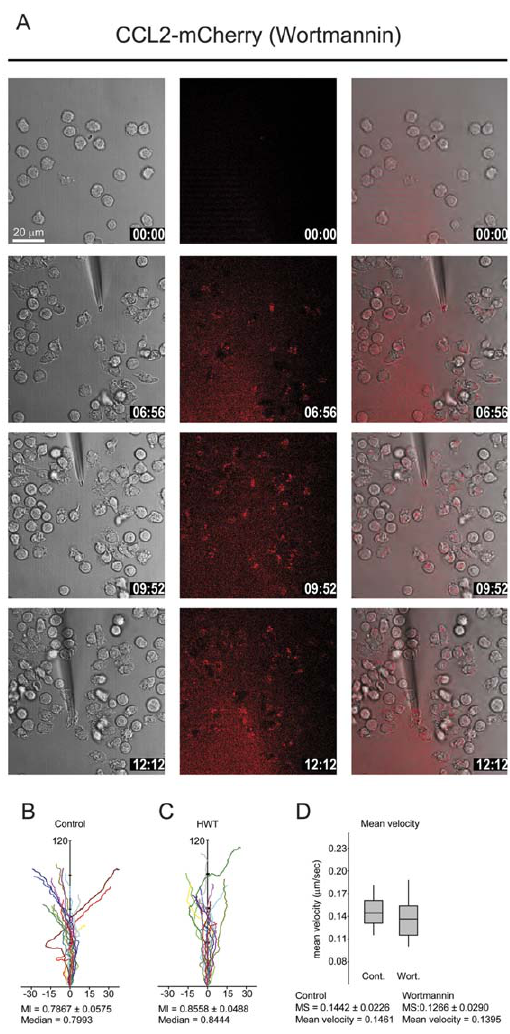
Figure 8. Inhibition of PI 3-kinase does not affect CCL2 uptake and monocyte migration. (A) Selected frames from time-lapse video microscopy (Movie S9) of migrating human monocytes recorded at 37 u C. Monocytes were pretreated with 100 nM wortmannin for 30 min. The micropipette was dispending 100 nM CCL2-mCherry with constant backpressure. Gray (left column) corresponding phase image. Left panels phase images, middle panels CCL2-mCherry (ex 594 nm/em 620–680 nm), and right overlay. Time stamps are indicated in mm:ss. (B and C) Analysis of directionality and velocity of monocytes: effect of PI 3-kinase inhibition. Tracks of monocytes (recorded as in Fig. 1 or Fig. 8A) either untreated (B) or pretreated with 100 nM wortmannin (C) were analyzed and plotted aligning their average directional vector with the y-axis (distance in m m). (D) Mean velocity of tracks shown in (B) and (C) were calculated using Metamorph software and median speed (MS) values are reported. Data from two independent observations, n=16 (A) and n=15 (B). MI=migratory index is the distance between the starting point and the end point divided by the total migrated distance.